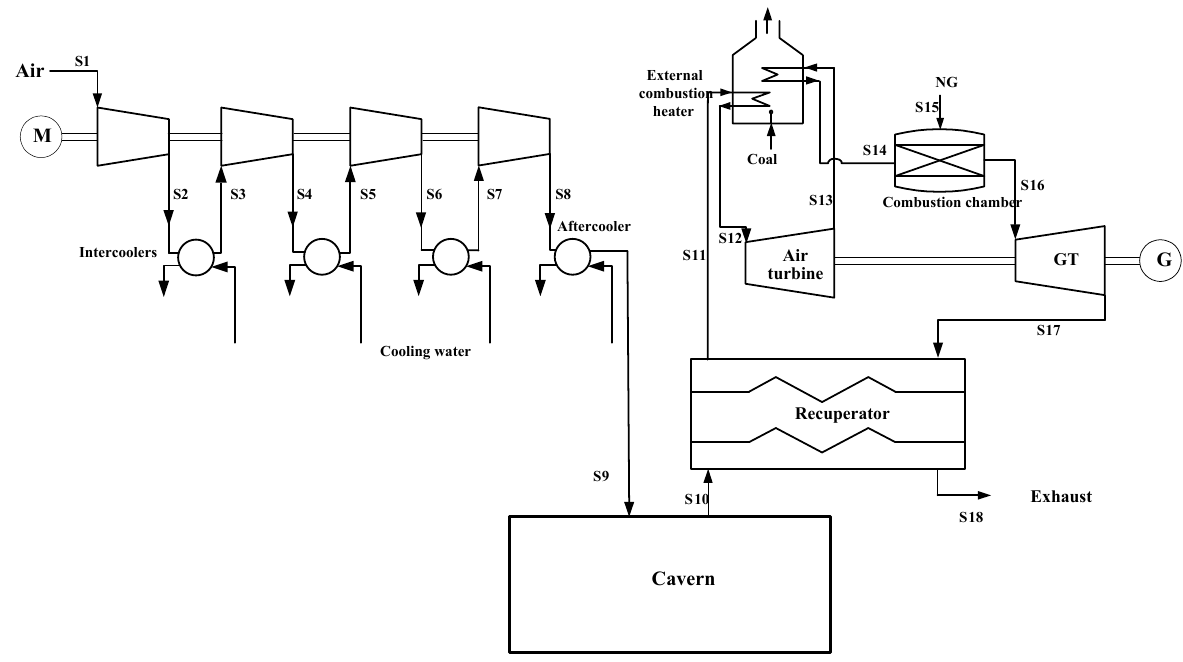
Figure 4. Flow sheet of the hybrid-fuel CAES